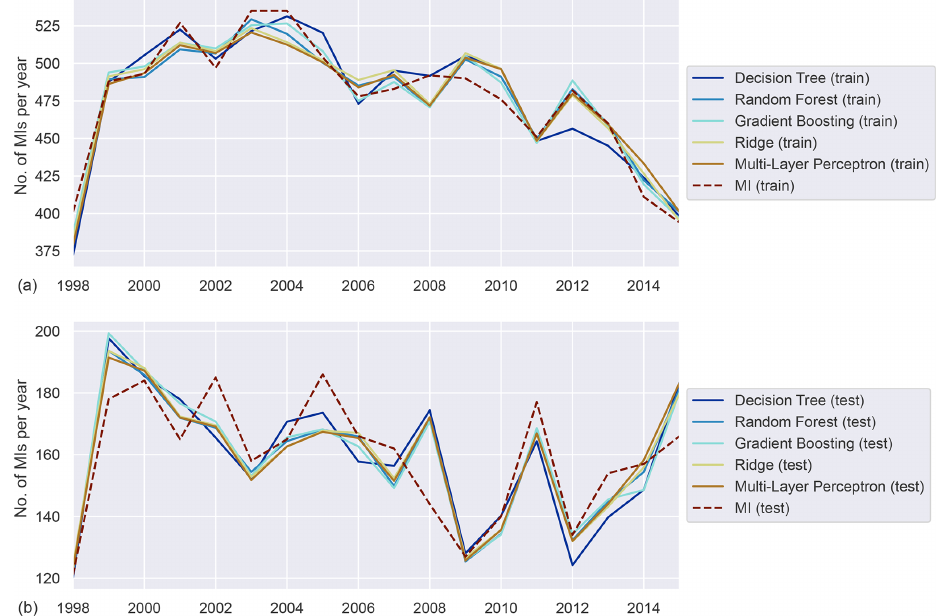
Figure A3. Annually aggregated predictions of MI in the elderly population for all models. Predicted (solid) and observed MI (dashed) for training (a) and test (b) sets.